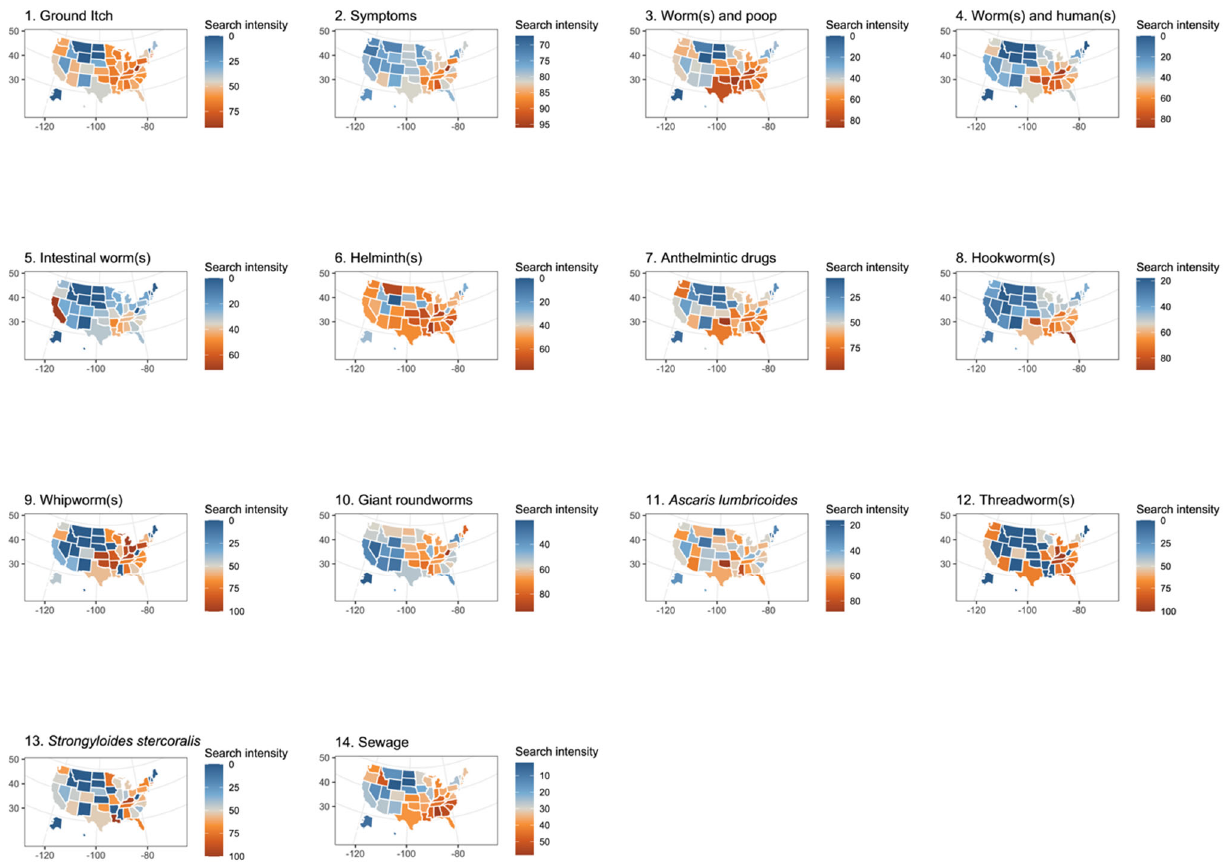
Figure 1. (1–13) Thirteen categories of search terms related to soil-transmitted helminths plotted by state using the mean of data from 2016 to 2021. (14) Category of search terms related to sanitation infrastructure deficiencies plotted by state using the mean of data from 2016 to 2021. The number for each map corresponds to Table 2, categories 1–14, showing the exact search terms used. Table 3. Estimate of spatial clustering (global Moran’s I) from state-level intensity of various search terms as well as unadjusted relationships (Pearson’s correlation coefficient with 95% confidence intervals) between search terms and various factors. The number for each outcome corresponds to Table 2 showing the exact search terms used. Items 1–4 and 6 represent percent of the population rather than absolute